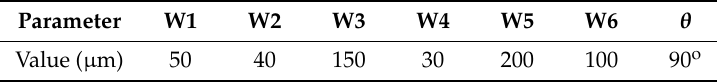
Figure 2. Geometry of proposed micromixer based ICEO. ( a ) 3D schematic diagram of the device with herringbone floating electrode sequence; ( b , c ) the fluidic sample motion on the left and right herringbone floating electrode surface under the asymmetrical ICEO vortex; ( d ) the specific dimensions of the microfluidic mixer device. Table 1. The specific geometric size of the micromixer.